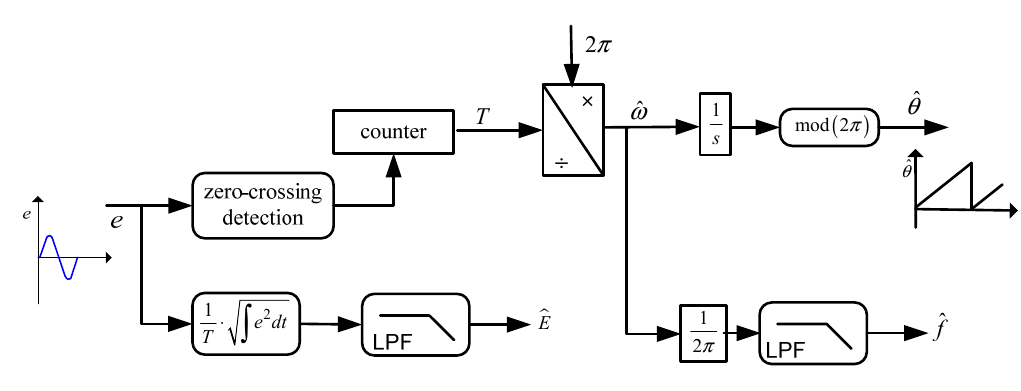
Figure 3. Zero-crossing detection (ZCD) structure.